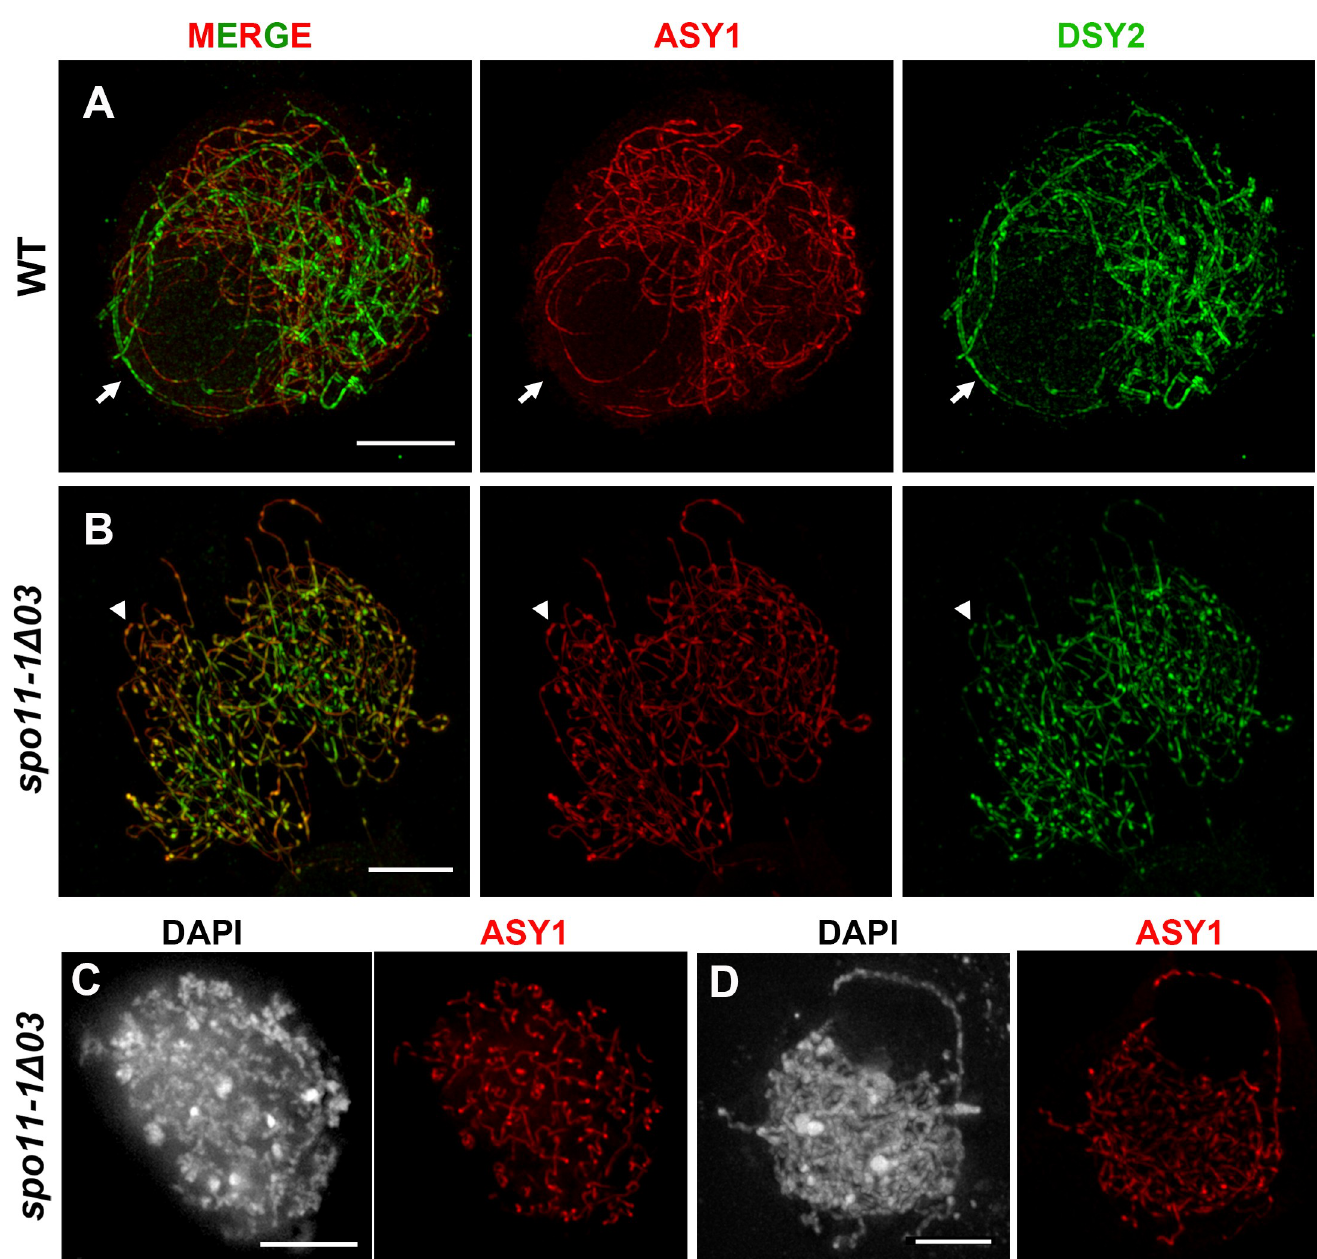
Fig 8. Axial element proteins ASY1 and DSY2 exhibit abnormal localization in spo11-1 mutants. (A, B) Zygotene meiocytes of the WT (A) and spo11-1 mutant (B) immunolabeled with ASY1 (red) and DSY2 (green), and observed by super-resolution microscopy. Note that synapsed regions in the WT (arrows) exhibit diminished ASY1 and enhanced DSY2 signals. In mutant meiocytes, both ASY1 and DSY2 accumulate abnormally (arrowheads). (C, D) Abnormal chromosome axes with curly and uneven ASY1 staining are observed in spo11-1 meiocytes. Scale bars represent 5 μ